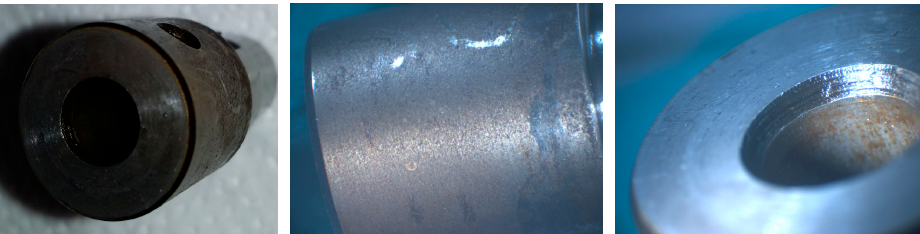
Figure 24. Details of wear on the pump cylinder.